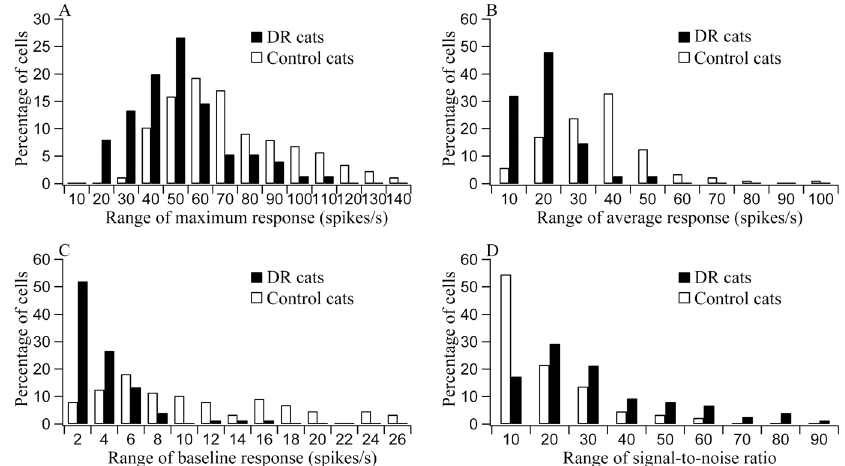
Fig 5. Percentage of neurons with different range of maximum response (MR) (A), average response (AR) (B), baseline response (BR) (C) and signal-to-noise ratio (STN) (D) for DR and normal control cats. The total number of neurons was 75 and 88 respectively for DR cats and control cats. DR cats showed significantly lower MR, AR and BR (all p < 0.0001), but significantly higher STN (p < 0.0001) when compared with control